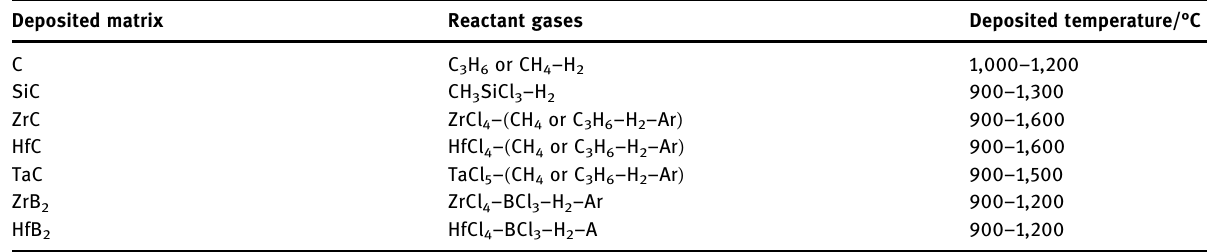
Deposited matrix Reactant gases Deposited